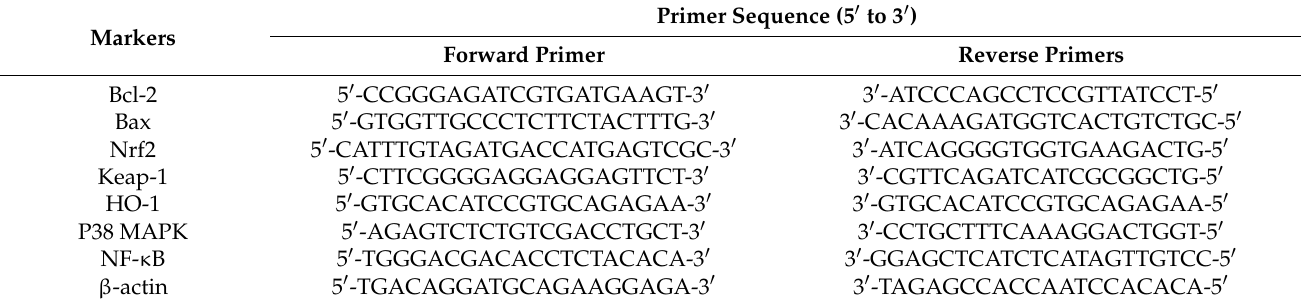
Table 1. Primer sequences for all markers used in real-time PCR